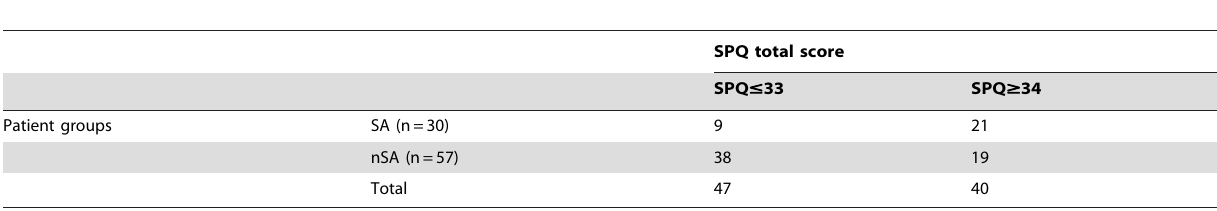
Table 3. Distributions of schizophrenia patients, with and without suicide attempts, scoring above and below the cut-off on the SPQ total